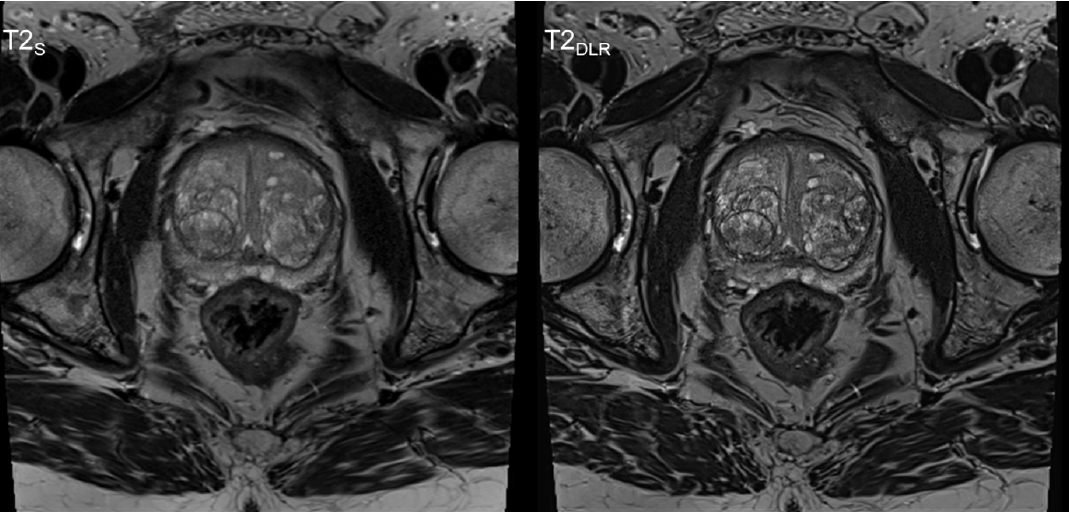
Figure 1. Sixty-year-old man with elevated PSA level. PI-RADS 2 score. No biopsy was performed. Deep learning image reconstructed thin-slice imaging (T2 DLR ) on the right-hand side with superior levels of sharpness and lesion detectability. Lesion detectability was also rated to be superior in T2 DLR , with a median of 4 (4–4) versus a median of 3 (3–4) in T2 S ( p < 0.001). The assessment of overall image quality re- sulted in superior ratings for T2 DLR , with a median of 4 (4–4), as compared to a median of 3 (3–3) for T2 S ( p < 0.001). Diagnostic confidence levels were also rated higher for T2 DLR , with a median of 4 (4–4) in comparison to a median of 3 (3–4) for T2 S ( p < 0.001). For image examples, see Figures 2 and 3.